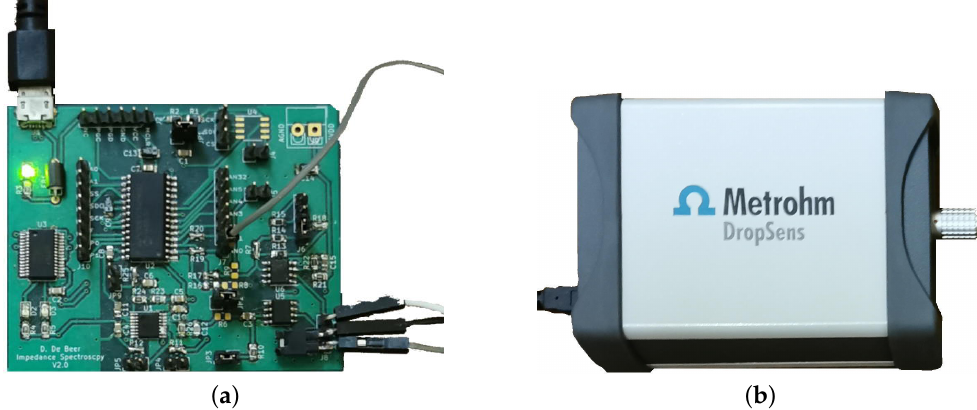
Figure 1. Two different impedance solutions. ( a ) Low-cost impedance analyzer (68.6 mm × 55.9 mm). ( b ) DropSens µStat-i 400s (132 × 100 mm) [30].